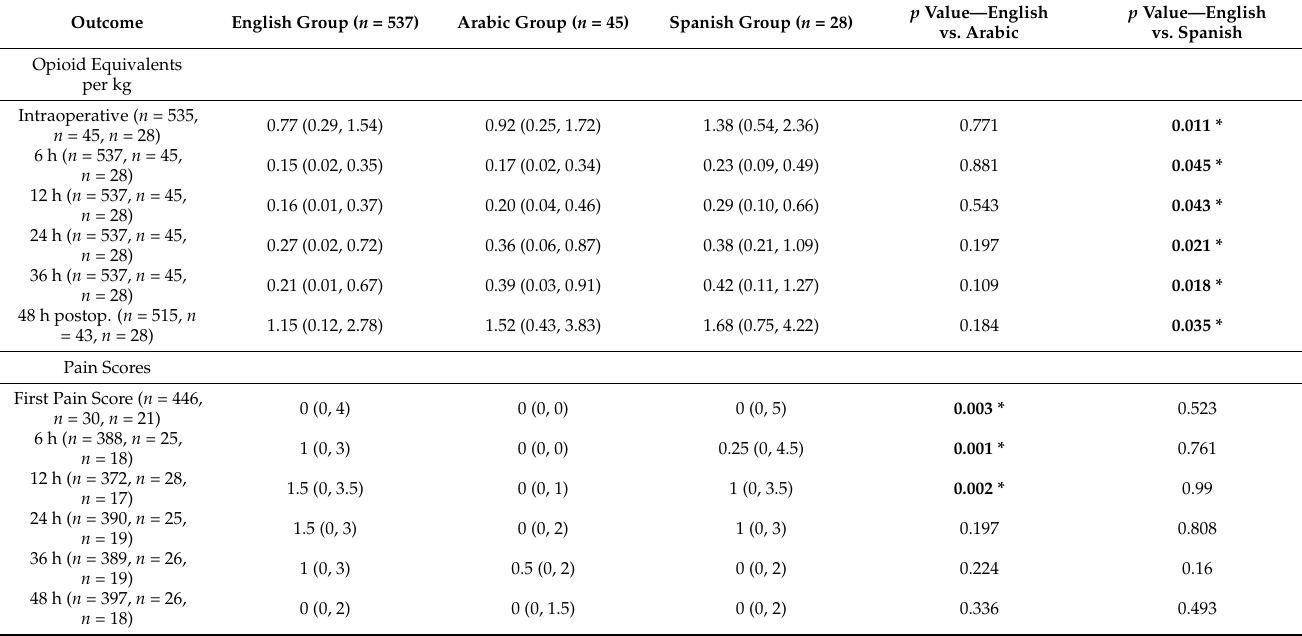
Data are presented as median (interquartile range). Sample sizes for patients with non-missing pain scores data (n) in each group are indicated. p values were calculated using the Wilcoxon rank sum test. * Statistically significant. The bold for p